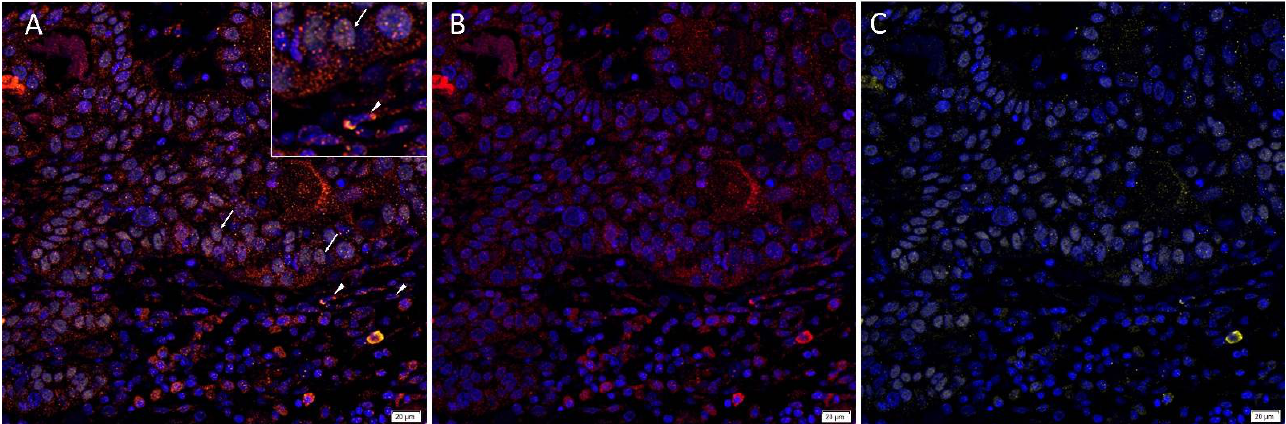
Cells 2021 , 10 , x FOR PEER REVIEW Figure 4. Representative merged and split immunofluorescence-stained sections of metastatic head and neck cutaneous squamous cell carcinoma demonstrating the expression of ACE ( A , B , red) by the CD31+ ( A , C , green) endothelium ( arrowheads ) of the tumor microvessels within the PTS. Cell nuclei were counter-stained with 4′6-diamidino-2-phenylindole ( A – C , blue). The inserts show enlarged views of the corresponding images Original magnification 400×. n = 2.